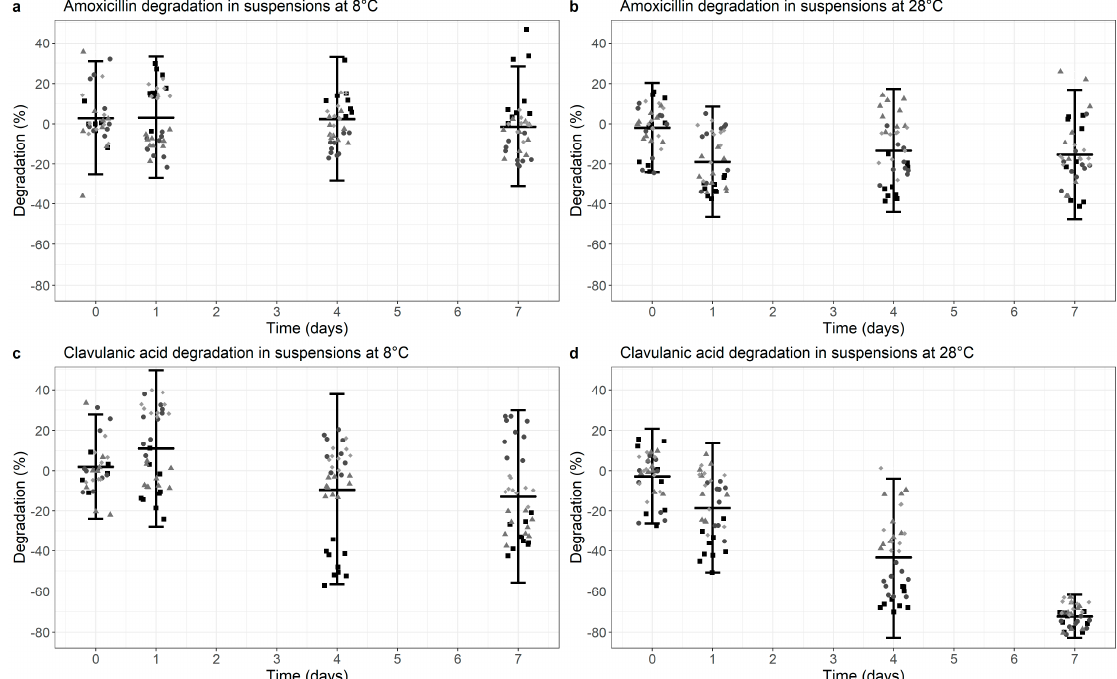
Figure 1. Degradation of Amoxicillin ( a , b ) and Clavulanic acid ( c , d ) in co-formulated suspensions at 8 °C ( a , c ) versus 28 °C ( b , d ). Degradation is normalized for the median value at time point 0 (0% degradation). Data points represent the normalized individual measurements for Augmentin Duo (square), Augmentin Trio (circle), Aziclav Duo (triangle) and Aziclav Forte (diamond). Cross bar represents the mean and the whiskers indicate the 95% confidence interval (mean ± 2 SD) per time point.